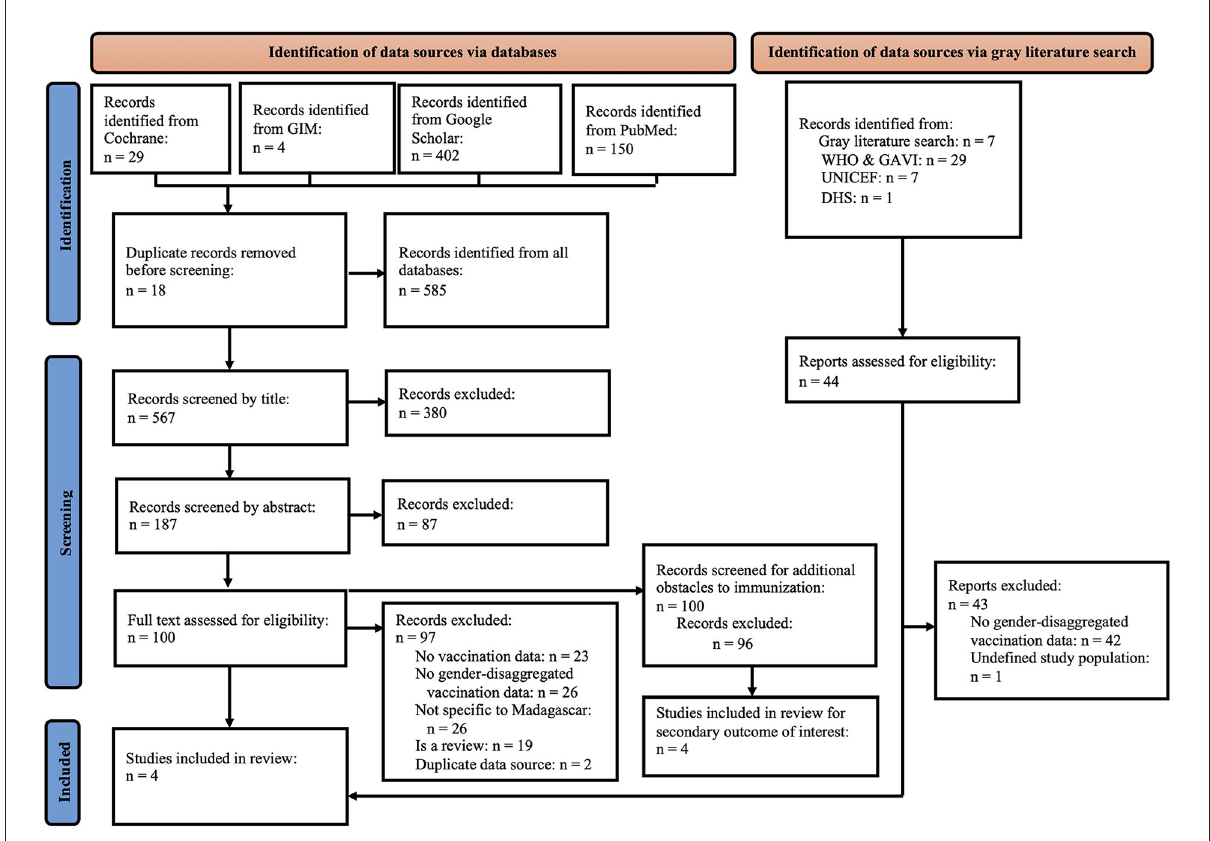
FIGURE1 PRISMA flowchart showing the number of articles screened by title, abstract, and full-text for the systematic and gray literature search and illustrating the inclusion and exclusion of articles as well as the reasons for exclusion. WHO and GAVI are listed together under gray literature search as WHO presented data from GAVI. DHS, Demographic Health Survey; GAVI, Gavi the Vaccine Alliance; GIM, Global Index Medicus; WHO, World Health